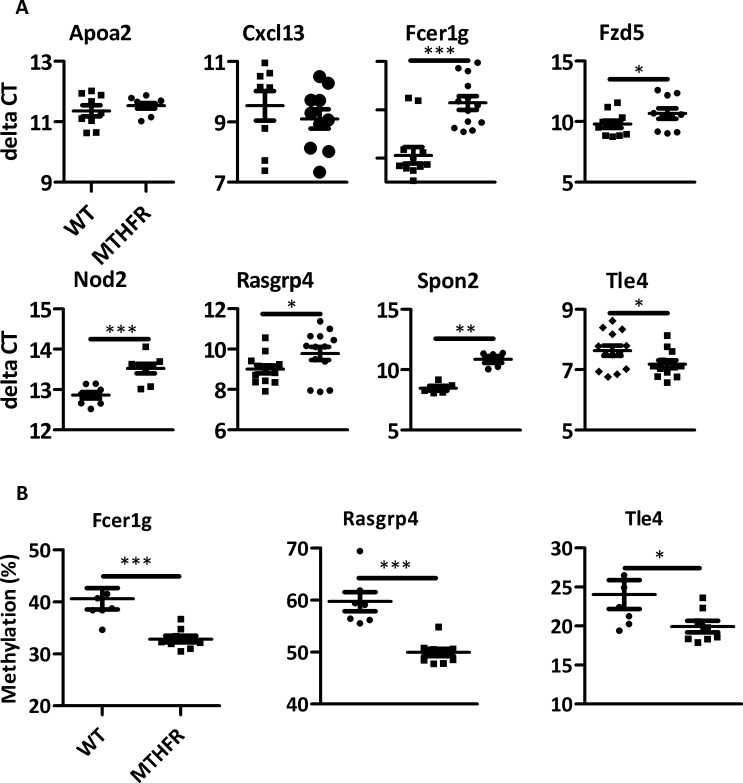
Expression and methylation results were confirmed.(A) 8 differentially expressed genes from the array data were quantified through RT-PCR. 6 out of 8 genes validated. (B) Rasgrp4, Tle4, and Fcer1g DMRs were validated through pyrosequencing. (* p-value <0.05, ** p-value <0.01 *** p-value <0.001).